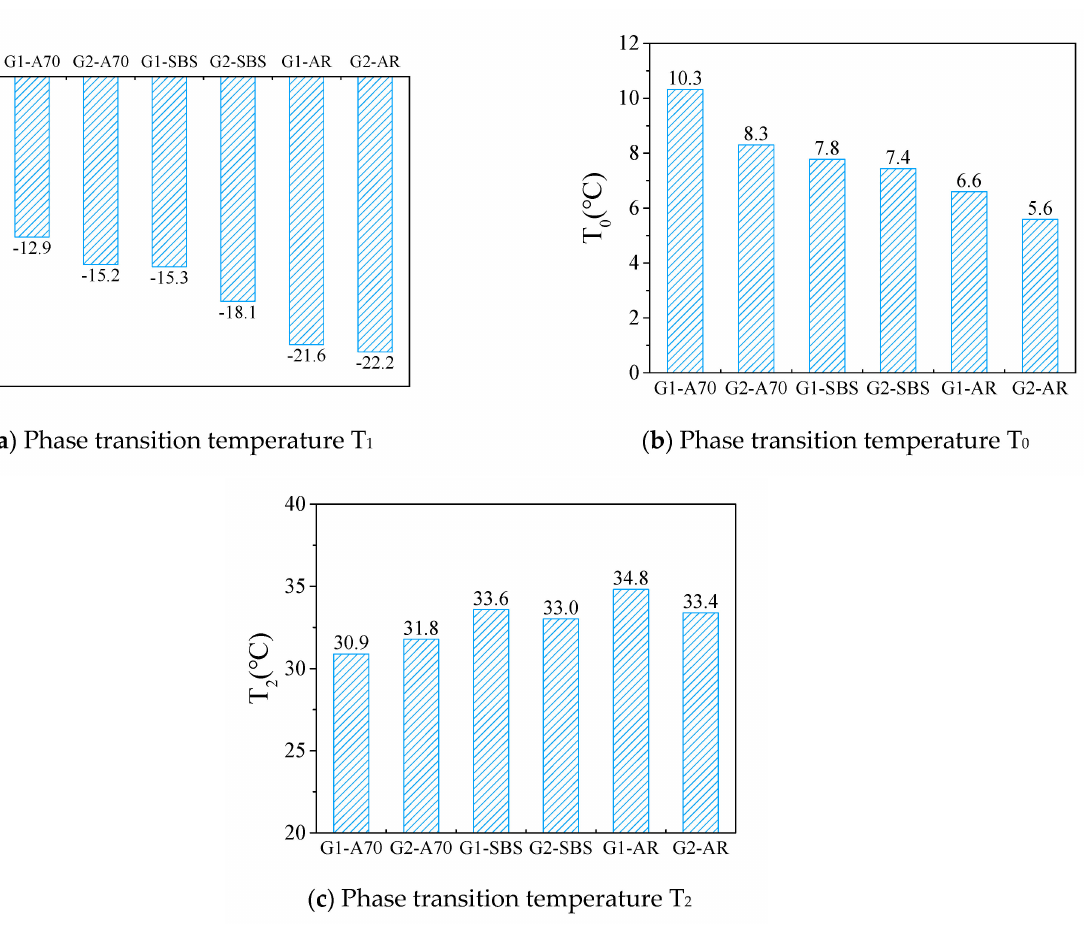
Figure 5. Phase transition temperature obtained from complex modulus (i.e., T 1 , T 0 , and T 2